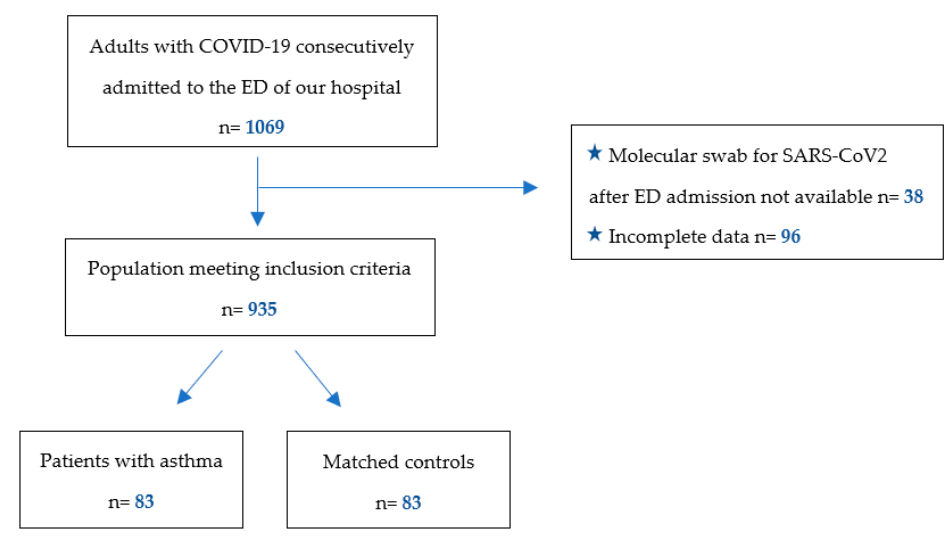
Figure 1. Flowchart of the study population. ED: emergency department. Table 1. Characteristics of cases and controls admitted to our ED for symptomatic